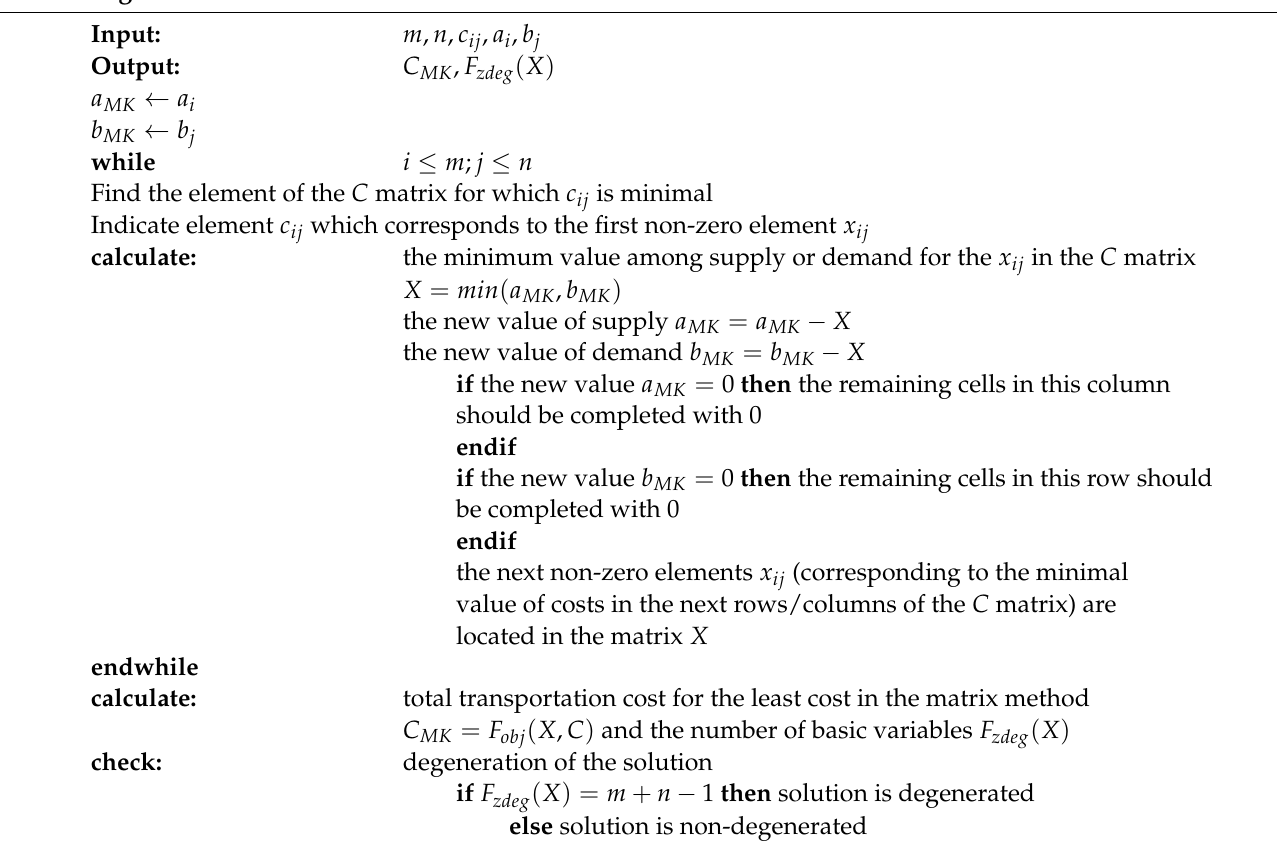
Algorithm 3 Pseudocode for the Least Cost in the Matrix